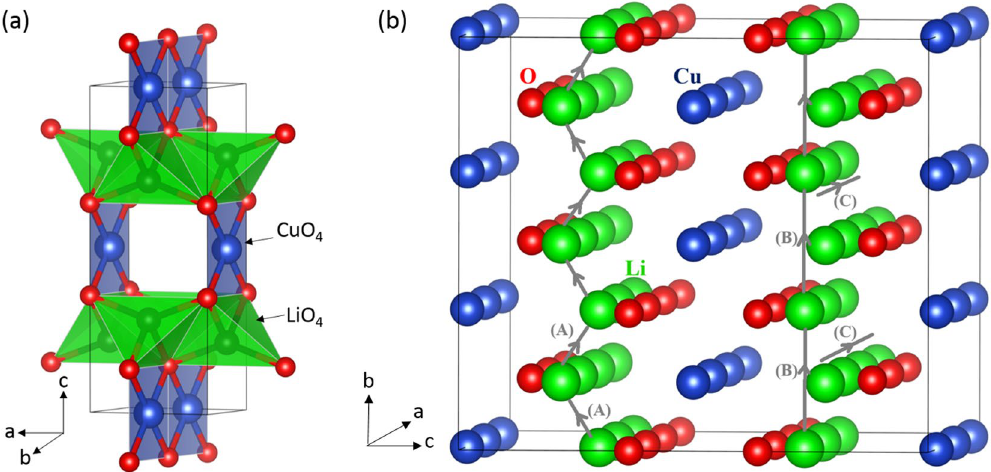
Figure 1. ( a ) Crystal structure of Li 2 CuO 2 (space group Immm ) and ( b ) the possible lithium ion migration paths considered. Li, Cu, and O atoms are shown as green, blue and red spheres